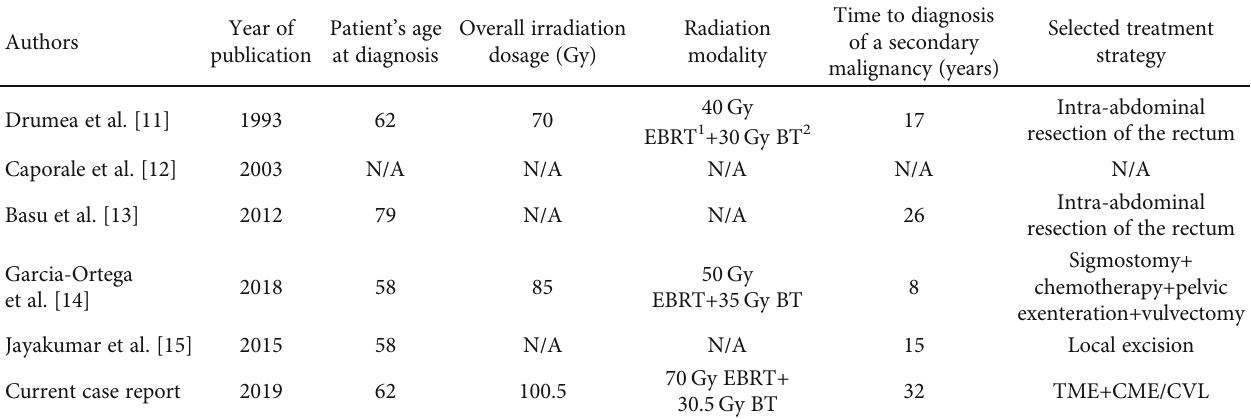
Table 1: Pooled data of all identi fi ed case reports of radiation-induced leiomyosarcoma of the rectum after pelvic radiation therapy for cervical